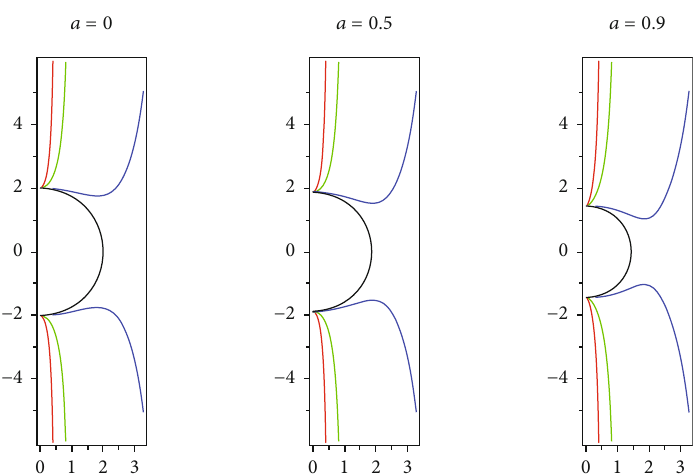
Figure 3: Contour plots depicting lines of constant ξ -values (31) for Example 1, using three di ff erent values of the Kerr parameter a . Red lines correspond to ξ = 0 : 5 , green to ξ = 1 , and blue to ξ = 4 . Along these lines the electromagnetic fi eld is, respectively, of the pure magnetic type, pure null type, and pure electric type; see (30). Green lines correspond to the light surfaces. a = 0 a = 0.5